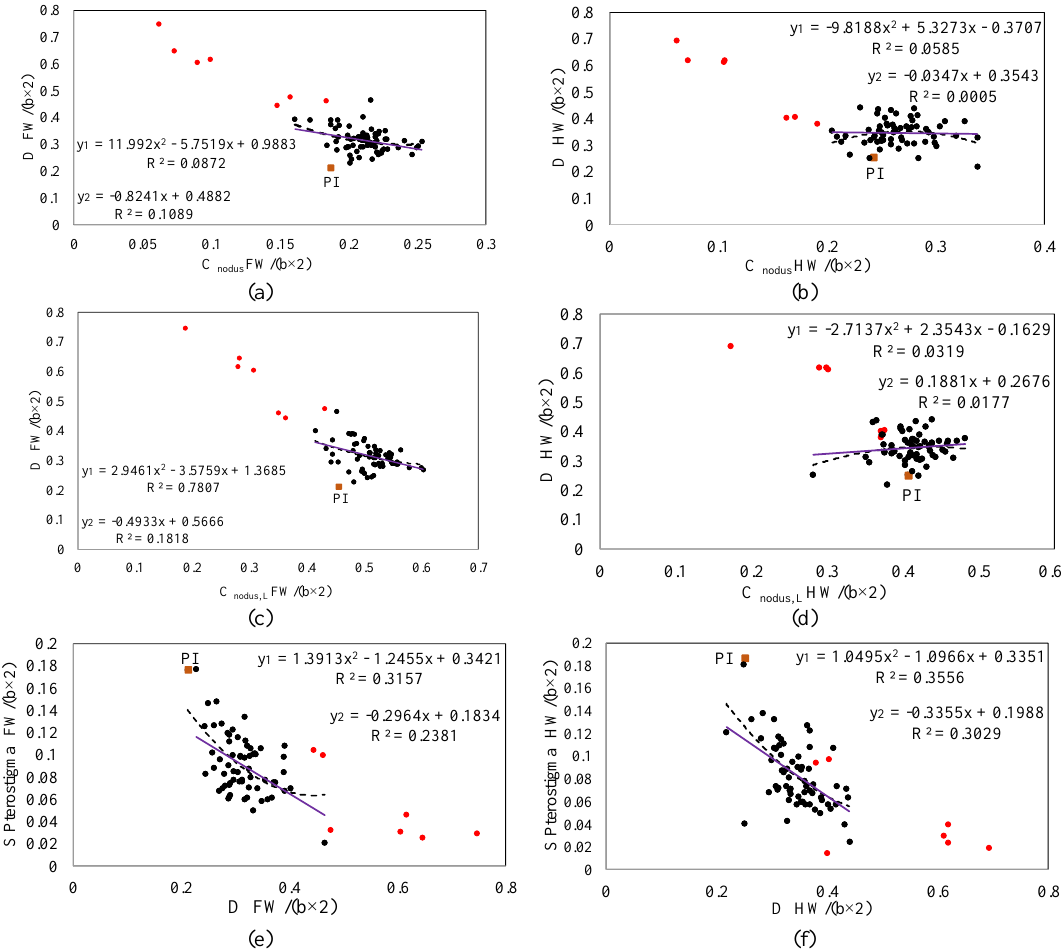
Figure 14. Nodus chord and pterostigma location versus wing semi-span of the forewings ( a ) and hindwings ( b ), nodus chord location and pterostigma location versus wing semi-span of the forewings ( c ) hindwings ( d ), and pterostigma size versus wing semi-span of the forewings ( e) and hindwings ( f ).